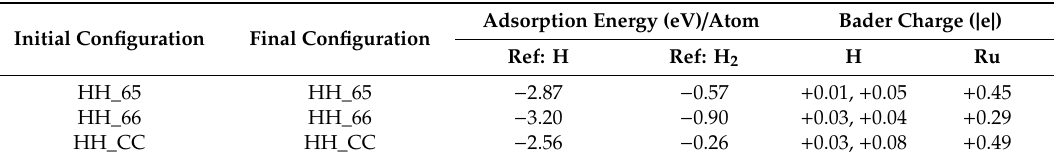
Table 5. Final configurations of two single H atoms adsorbed on the surface of Ru@C 60 , adsorption energies with respect to gas phase hydrogen atom and Bader charges on the Ru and H atoms.